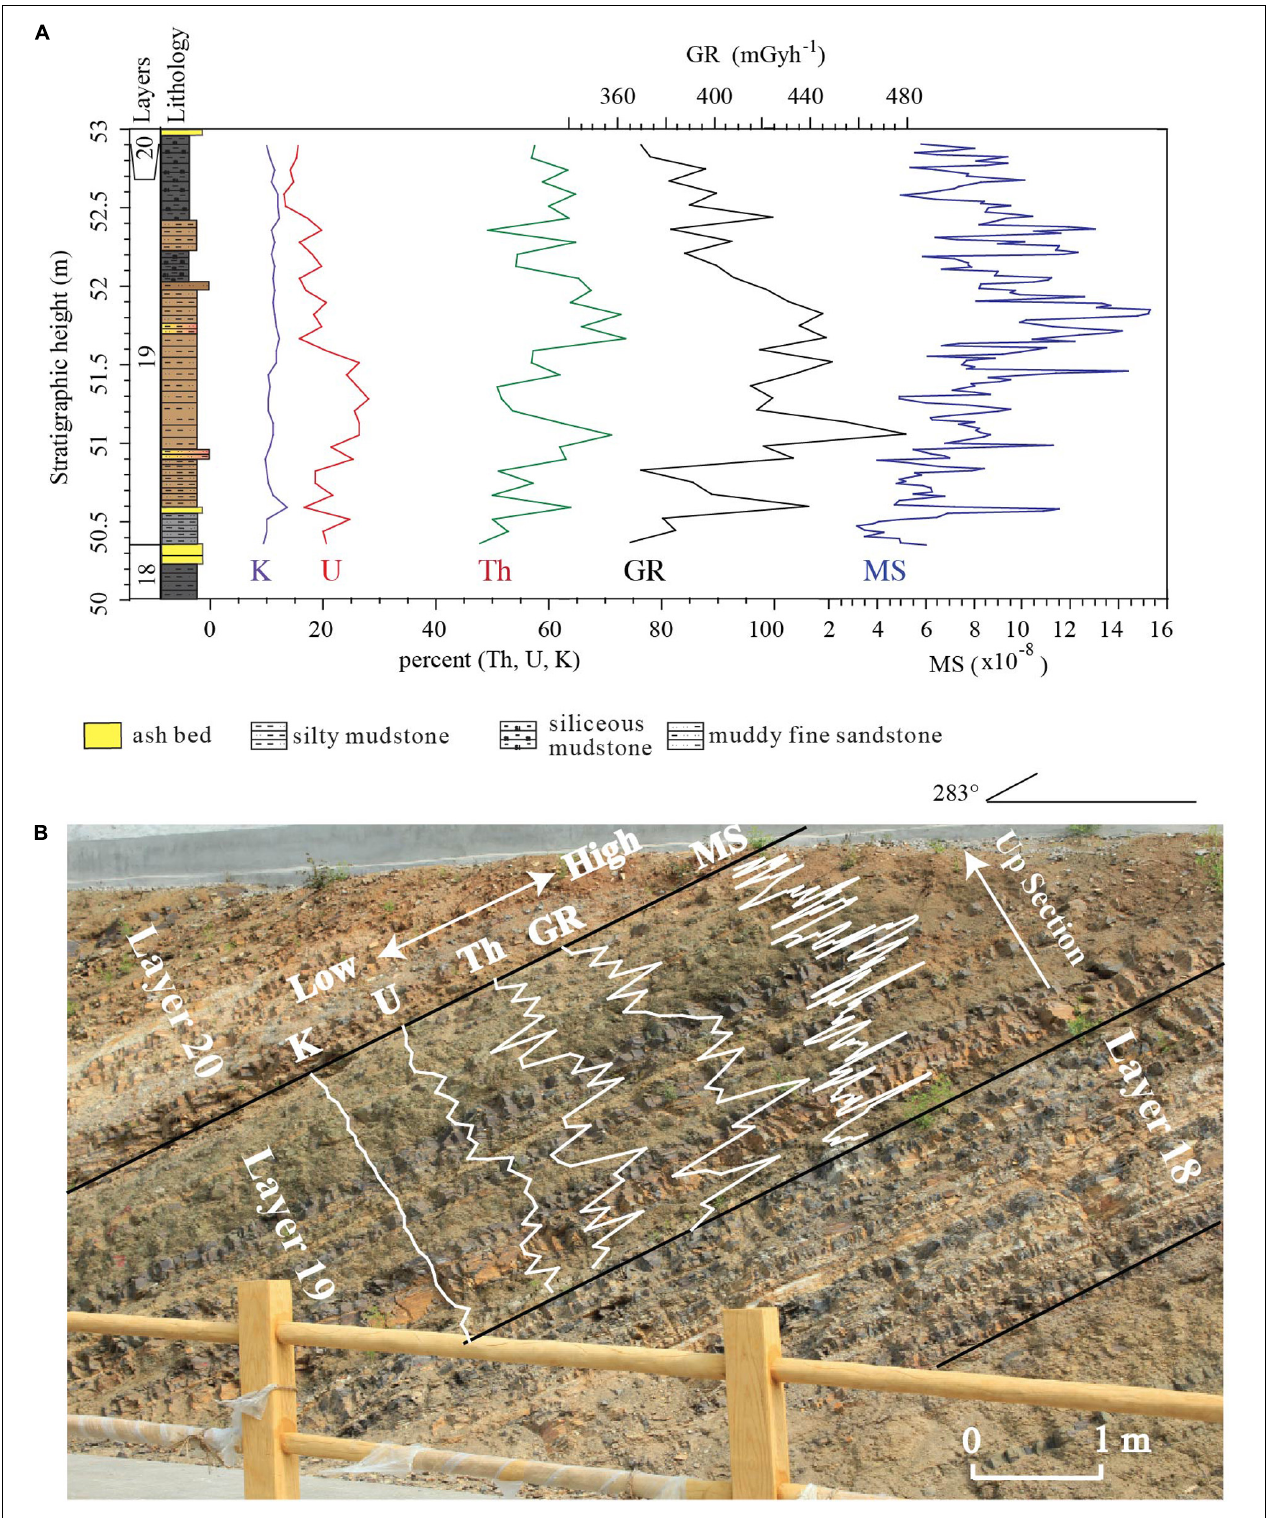
FIGURE 3 | (A) Comparison of lithology, MS, gamma ray (GR) intensity, and percent (%) of Th, K and U contributions in Layer 19. (B) Outcrop photo of Layers 17–20 with in situ measured data from Layer 19.